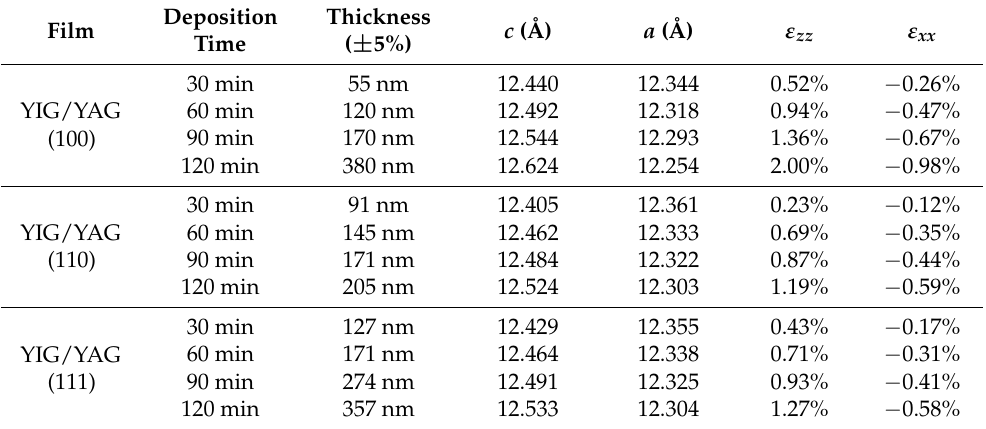
Table 1. Thickness of YIG films on (100), (110), and (111) YAG as a function of deposition time. Estimated out-of-plane lattice constant c , in-plane lattice constant a , the out of plane strain ε zz , and in-plane strain ε xx for YIG films on YAG (100), (110), and (111) substrates.